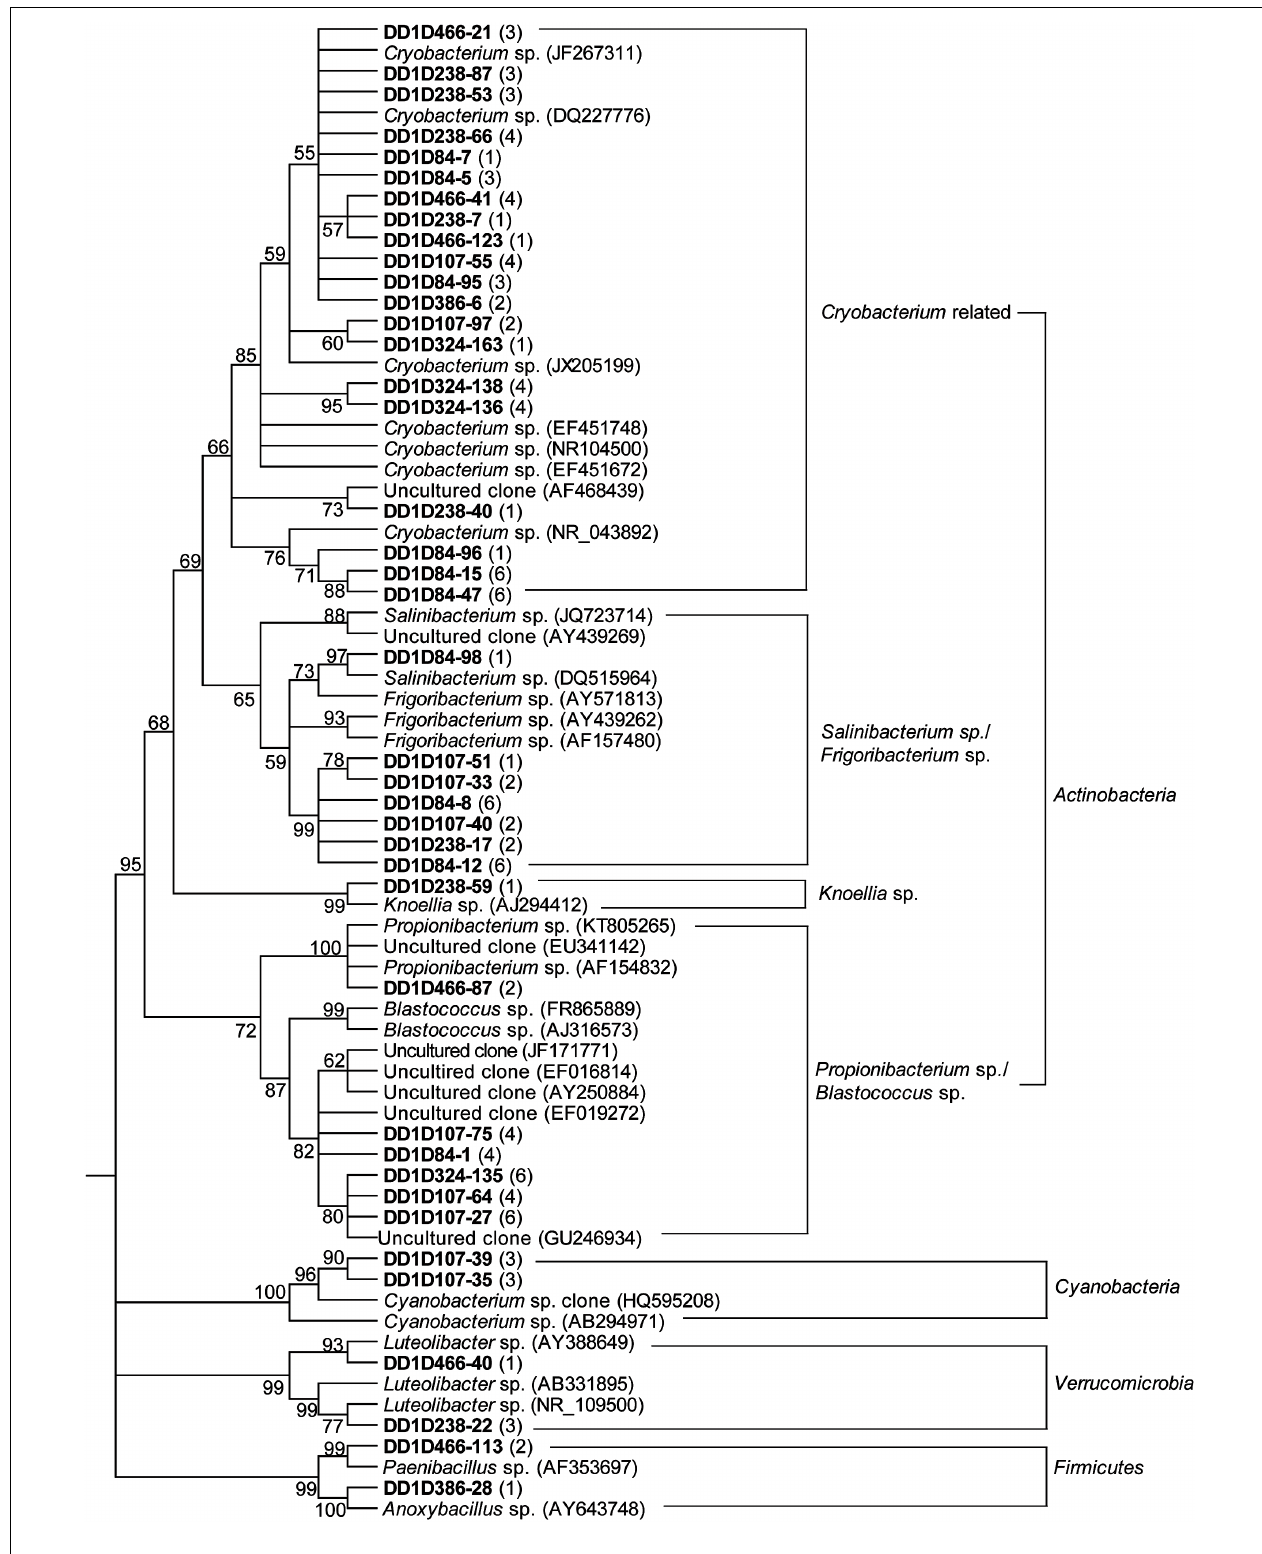
FIGURE 6 | Phylogenetic analysis of the 16S rRNA genes for the Actinobacteria , Cyanobacteria , Verrucomicrobia , and Firmicutes clones from the Dunde ice core and the closest relatives. The tree was constructed by following the protocol as described in Figure 5 .